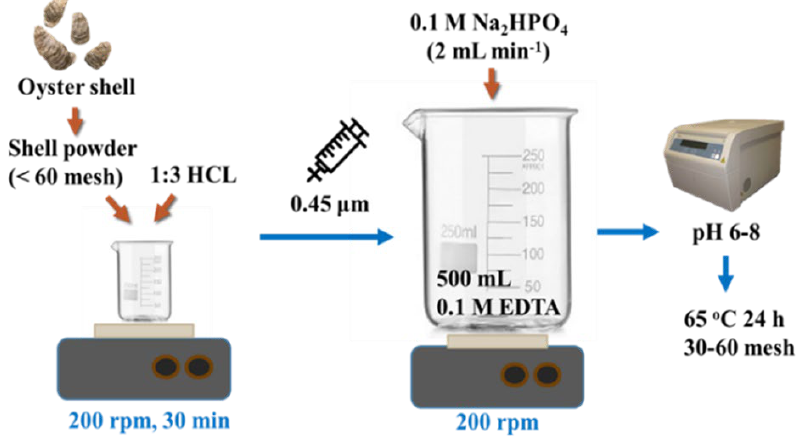
Figure 1. The process of synthesizing HAP.